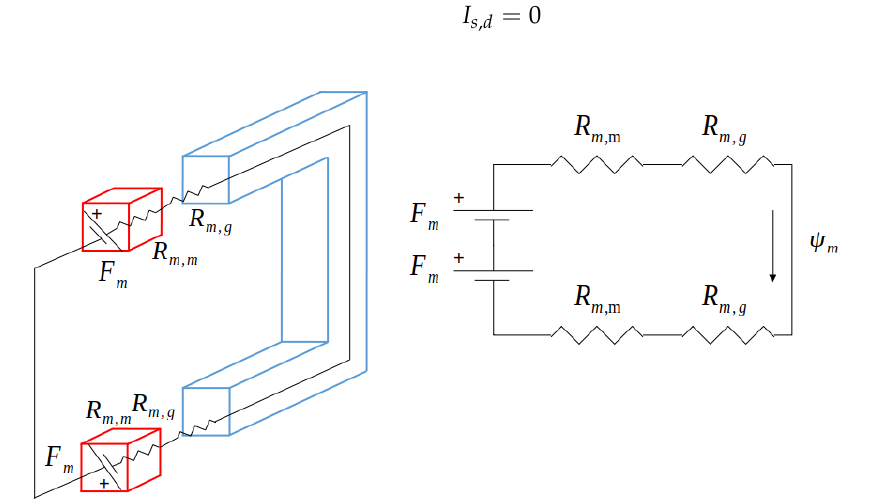
Figure 6. Magnetic circuit of one pole pair (no-load) in the d-position.